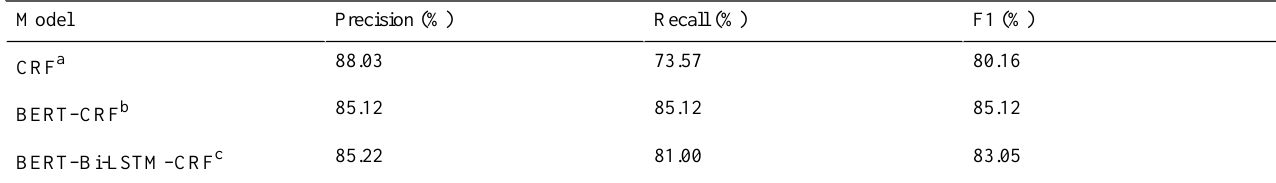
Table 3. Performance of the